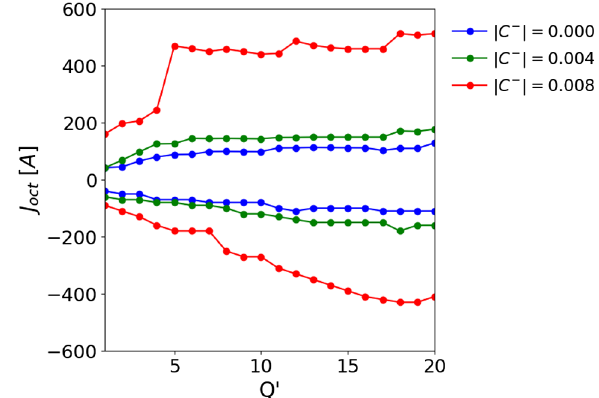
FIG. 13. Required stabilizing octupole current in the horizontal plane from P Y SSD as a function of Q 0 for different values of j C − j . This figure uses the LHC 2016 impedance model for an energy of E ¼ 6 . 5 TeV. Constant tunes of Q u ¼ 0 . 31 , Q v ¼ 0 . 32 were maintained for each point, with τ d ¼ 50 turns, M ¼ 2748 bunches and β (cid:3) ¼ 40